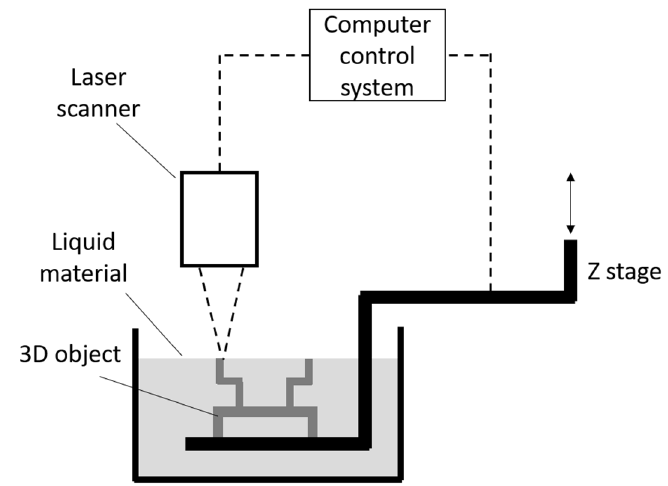
Figure 1. Hull’s stereolithography system.